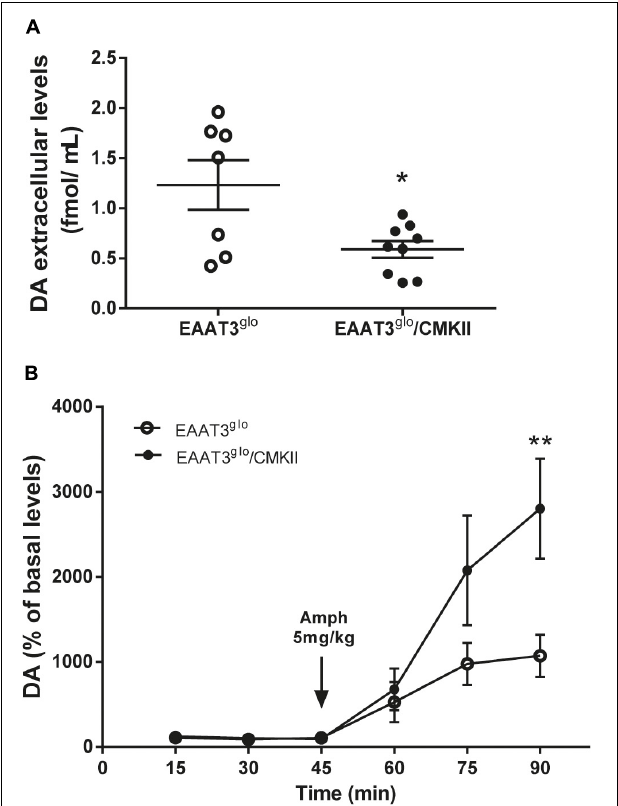
FIGURE 3 | Decreased basal dopamine (DA), but enhanced amphetamine-induced DA levels in EAAT3 glo /CMKII mice. In vivo microdialysis was done in the striatum of anesthetized mice. Samples were collected every 15 min; three samples were taken in basal conditions and after acute administration of amphetamine (5 mg/kg s.c.). (A) Basal DA extracellular concentration in the striatum. Graph shows the average of the three samples taken for basal DA concentration. * p = 0.0163 according to unpaired t -test. (B) Temporal course of amphetamine-induced DA release. Data are expressed as percentage of basal DA levels. ** p < 0.01 according to two-way ANOVA and Bonferroni’s posttest. EAAT3 glo n = 7 (5M, 2F); EAAT3 glo /CMKII n = 9 (5M,